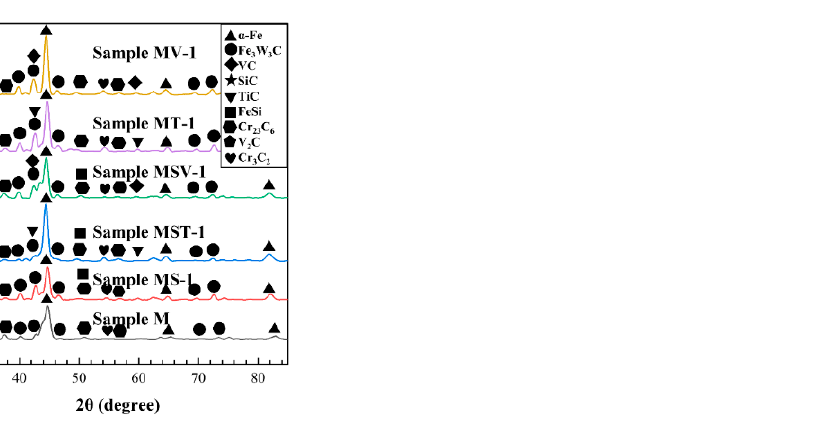
Figure 5. The XRD patterns of designed S390 MMCs designed in this study.